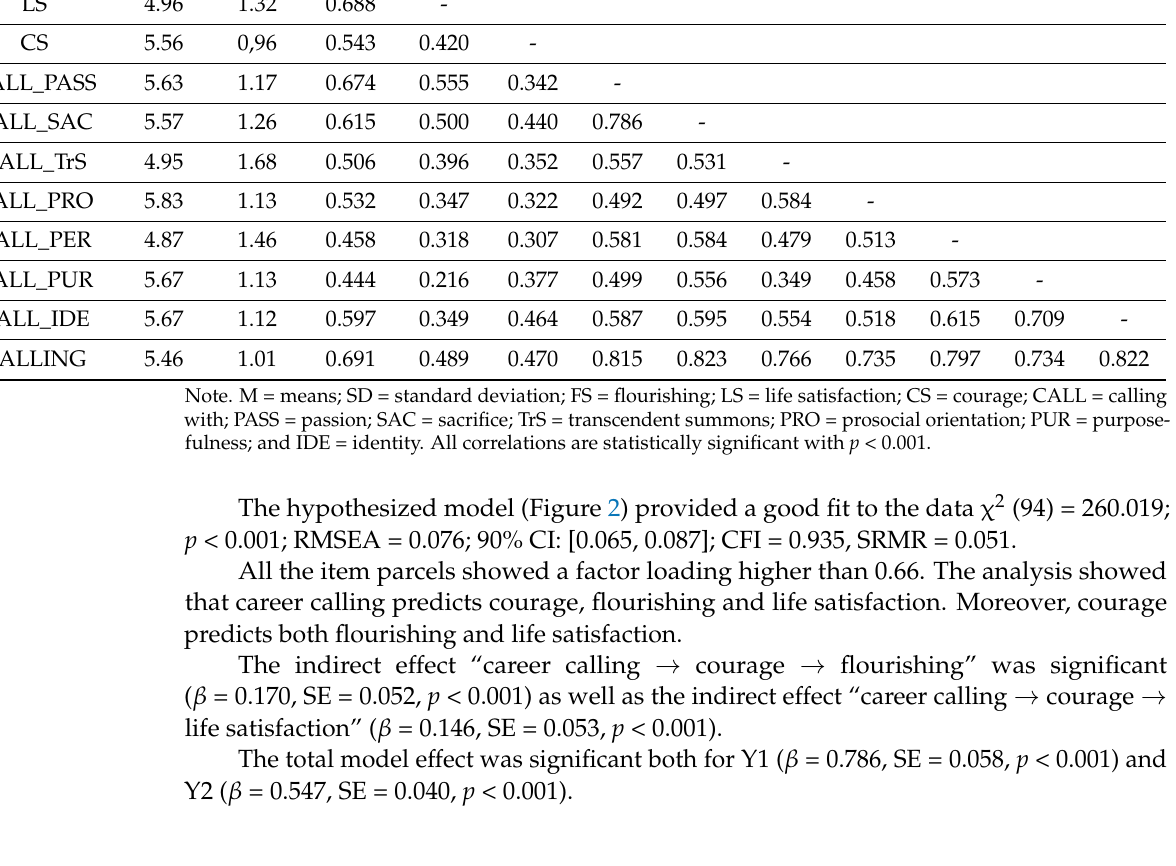
Table 1. Means, standard deviations and correlations among study variables.